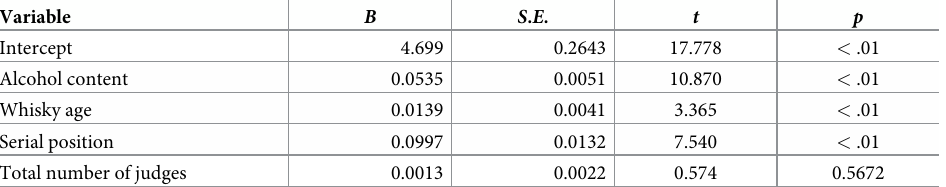
Table 2. Summary of the relative impact of the predictors in the multilevel model with tasting and whisky as lev- els, and the mean overall rating of each whisky as the outcome variable. Variable